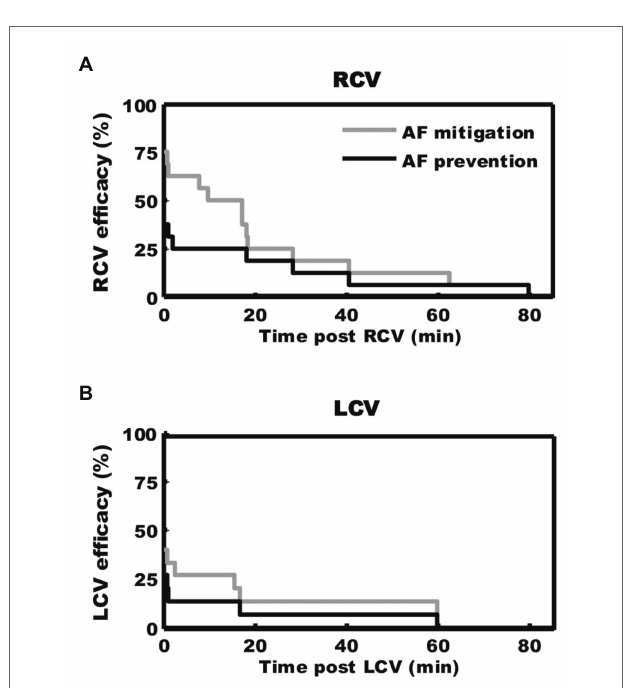
FIGURE 7 | Kaplan-Meier curves demonstrating duration of antiarrhythmic effects of 3 min of preemptive cervical vagal nerve stimulation. After right (A) or left (B) sided vagal nerve stimulation, mediastinal nerve stimulation was less effective in inducing atrial fibrillation for approximately 30 min. Adapted from Salavatian et al.